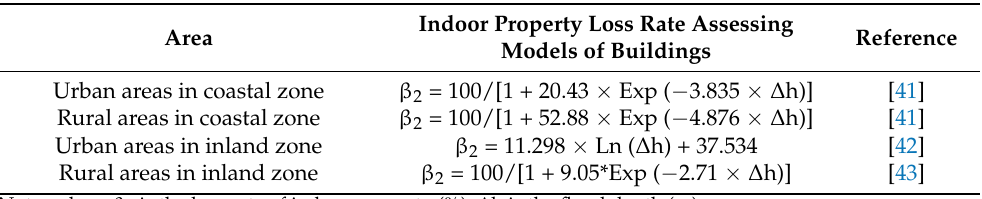
Table 4. Applicable curve of the indoor property loss rate of buildings in different areas of Haikou